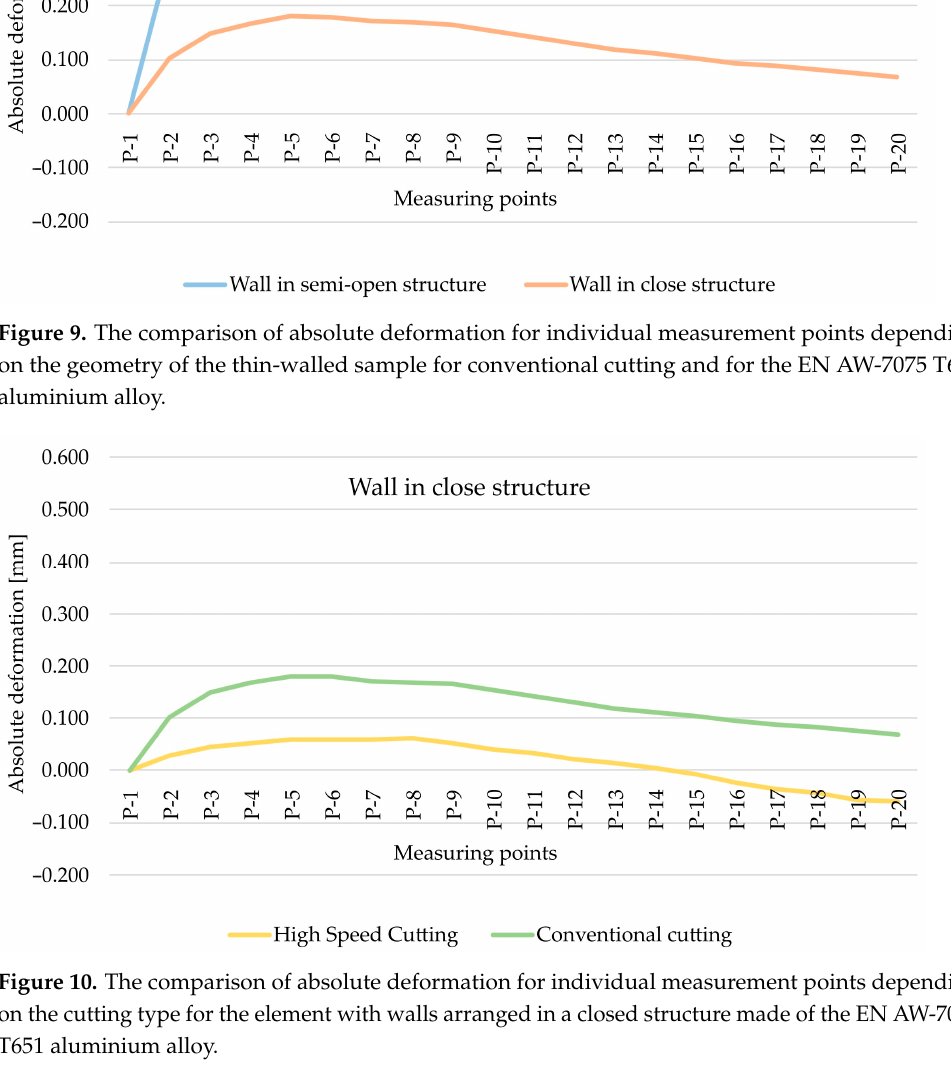
Figure 10. The comparison of absolute deformation for individual measurement points depending on the cutting type for the element with walls arranged in a closed structure made of the EN AW- 7075 T651 aluminium alloy.